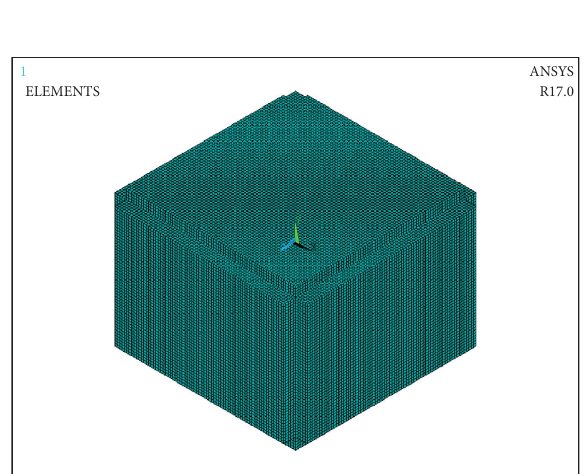
Figure 7: Finite element